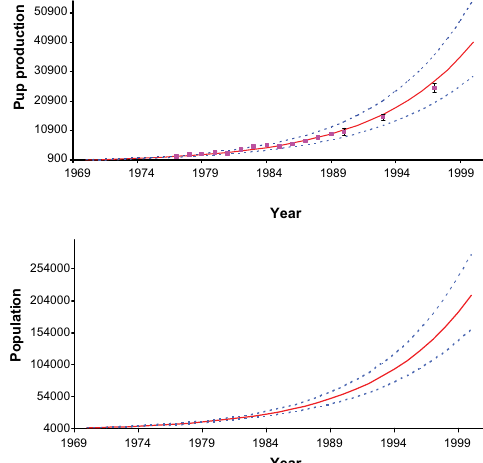
Fig. 7. Pup counts/survey estimates (±95% CI) and predicted pup production on Sable Island (top) and predicted changes in total population size (bottom) between 1970 and 2000. Dotted lines represent 95% confidence intervals (CI).